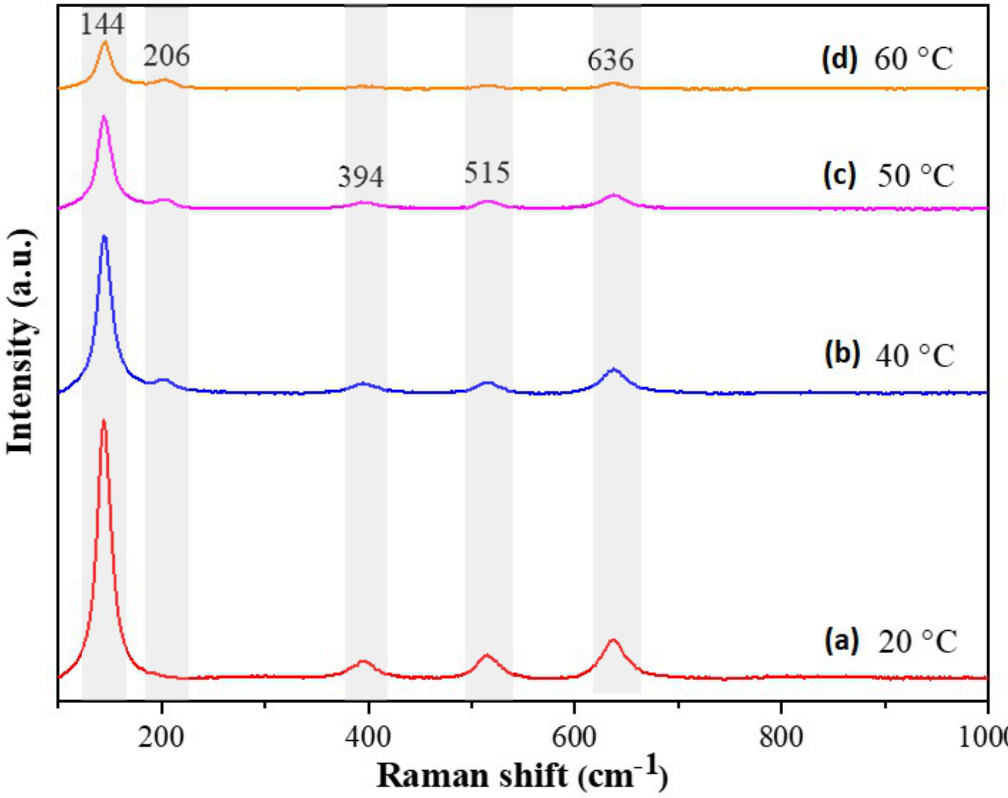
Figure 4. Raman spectrum of CdSe–TiO 2 nanotube thin films soaked at ( a ) 20 °C, ( b ) 40 °C, ( c ) 50 °C, and ( d ) 60 °C in 5 mM CdSe solution for 1 h .